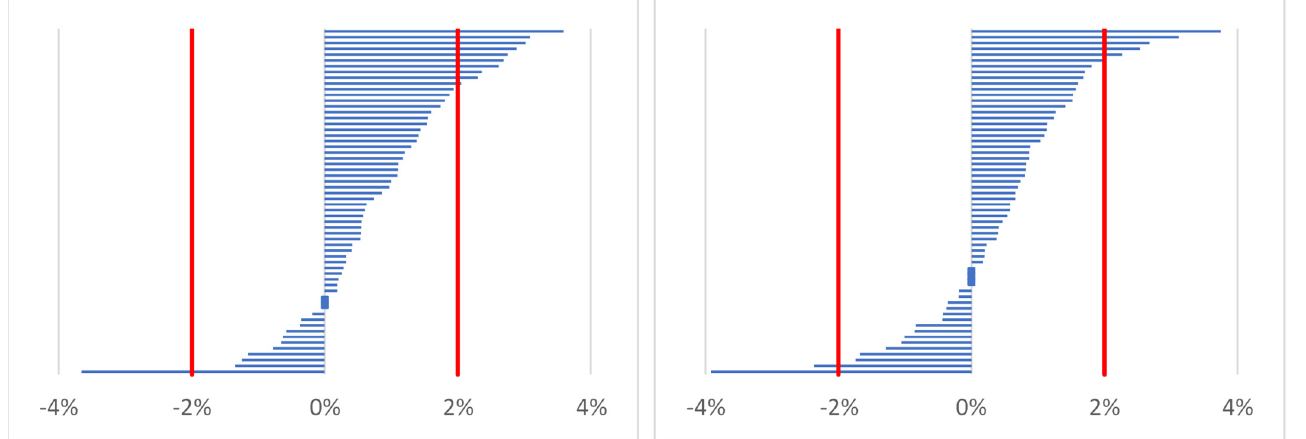
Figure 2. Distribution of changes in total body water for time point 2 (after work; on the left) and time point 3 (before work on the following day; on the right) vs. time point 1 (before work/baseline) in all participants ( n = 60).